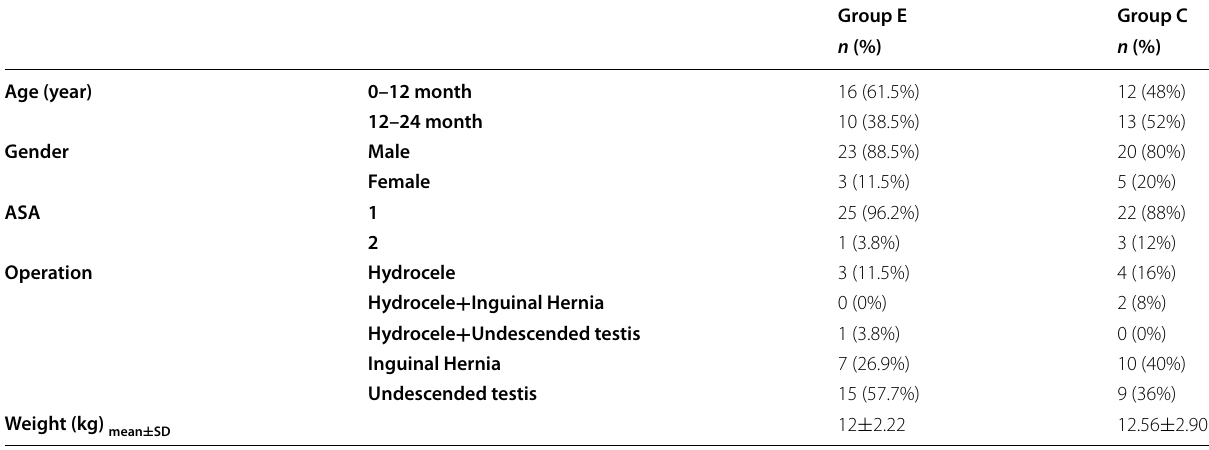
Values are mean (SD) or count (percentage) ASA American Society of Anesthesiologists physical